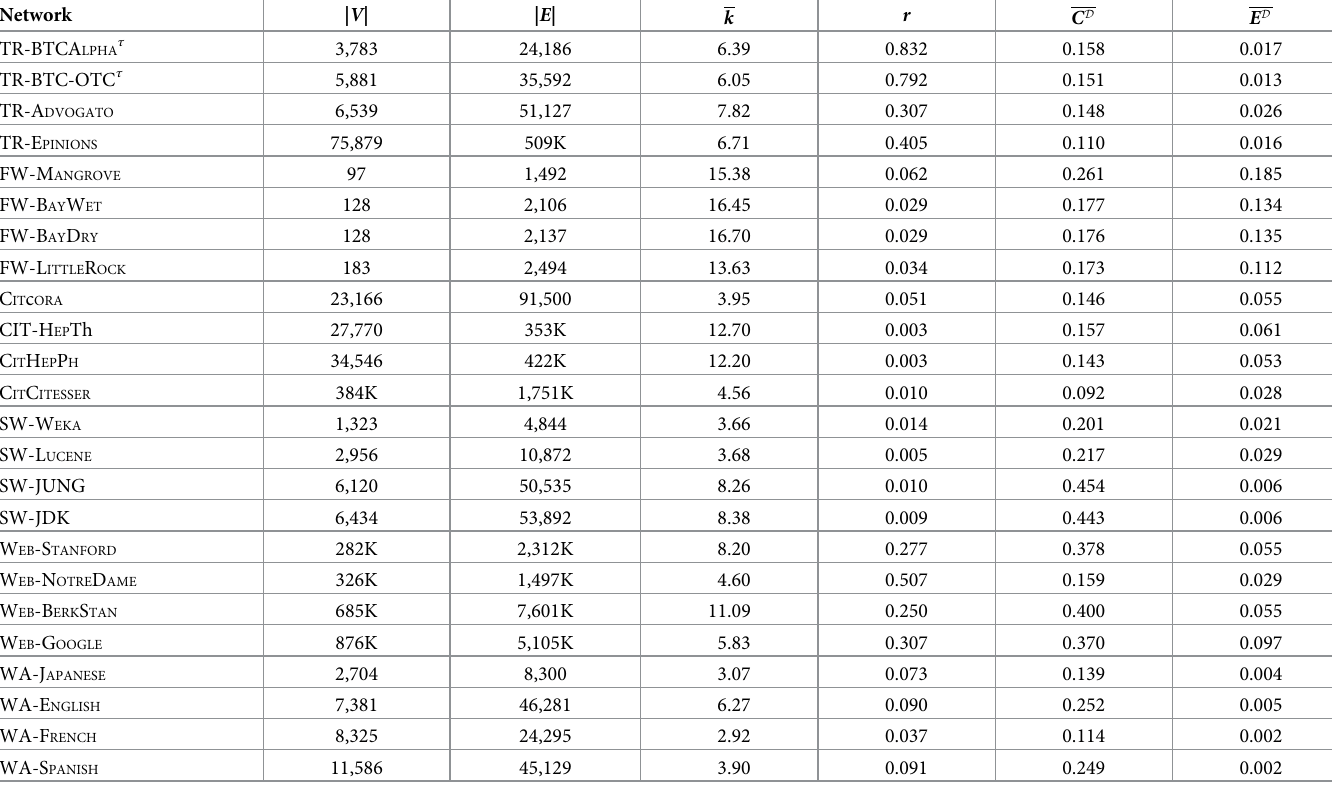
Table 1. Statistics of datasets, showing the number of nodes (| V |), the number of edges (| E |), the average degree( k ), the proportion of reciprocal edges ( r ), the aver- age directed clustering coefficient ( C D ), and the average directed closure coefficient ( E D ). Datasets having timestamps on edge creation are superscripted by ( τ